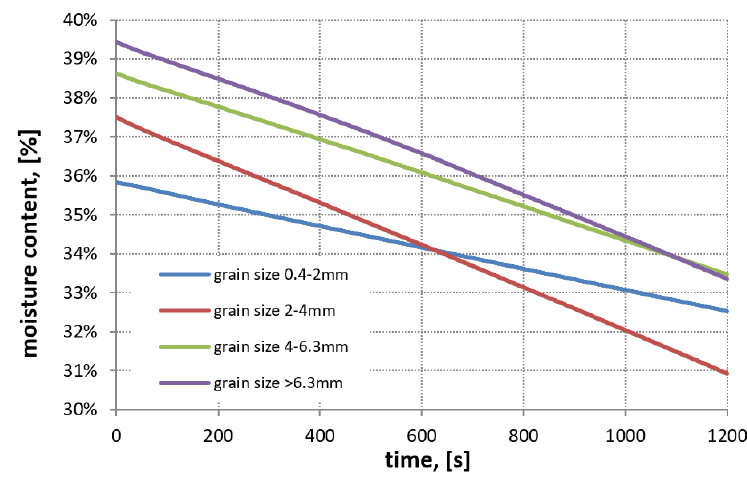
Figure 10. Effect of lignite grain size on the drying process at 35 °C for Turów lignite.